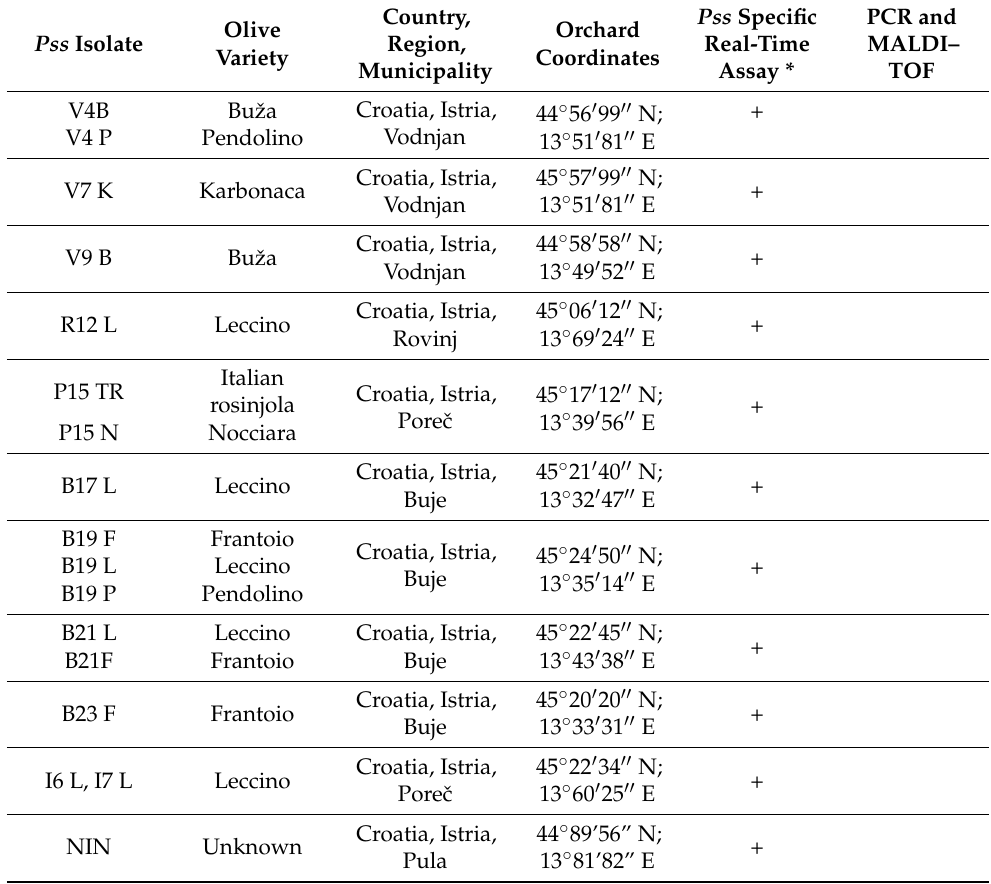
Table 2. Pss isolates identified in olive varieties from Croatian, Slovenian and Portuguese orchards with the relevant olive orchards’ coordinates and the molecular methods used for pathovar